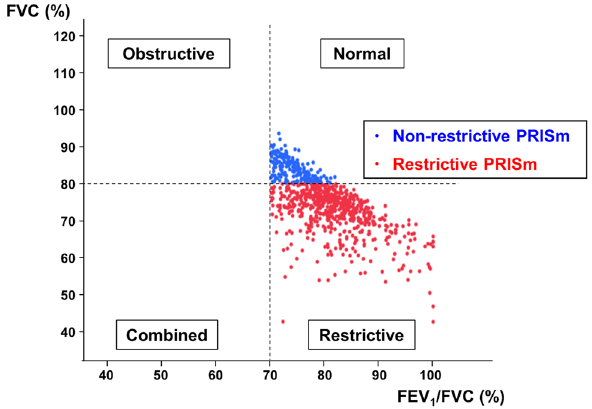
Figure 2. Distribution of spirometric results of participants with restrictive and non-restrictive PRISm. FEV 1 — forced expiratory volume in 1 s; FVC—forced vital capacity; PRISm—preserved ratio impaired spirometry.